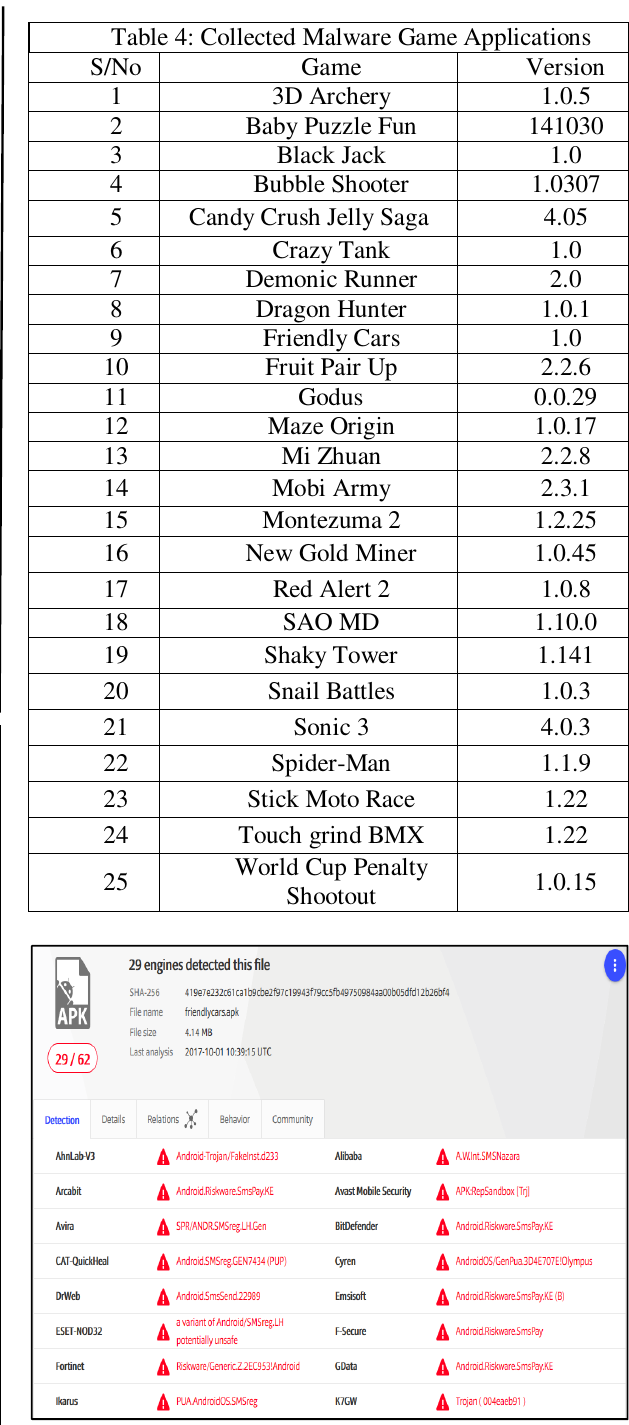
Fig. 5: Scan Results of Malware Games